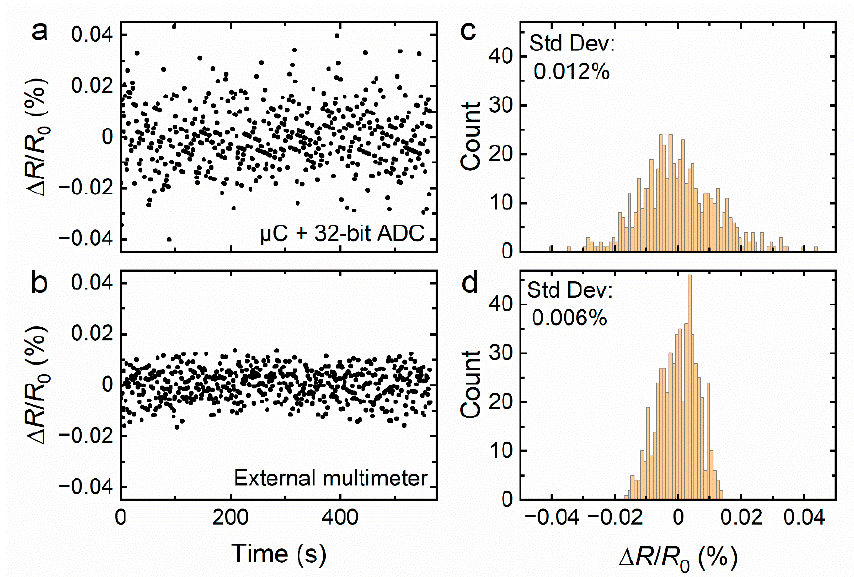
Figure 4. Resistance measurements of a graphene sensor under steady state conditions ( a ) measured with our sensing platform combining a µ C and 32-bit ADC, and ( b ) extracted from the linear I-V characteristic curve obtained by an external multimeter (Keithley 2400) by keeping the voltage constant and reading the current. ( c , d ) show the statistical distribution of the time-dependent data presented in ( a , b ), respectively.